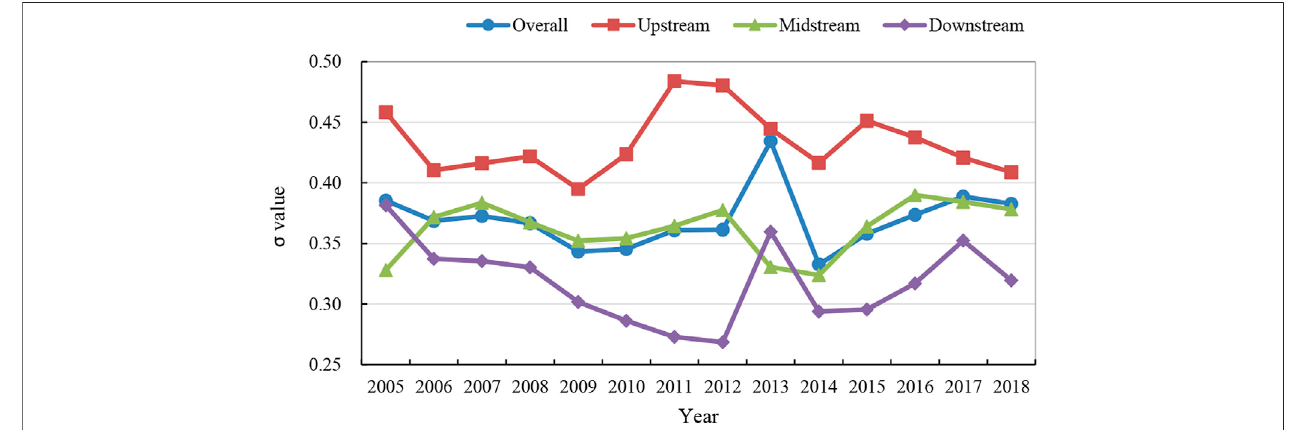
FIGURE 3 | Trends of ecological ef fi ciency σ in the Yellow River Basin from 2005 to 2018.